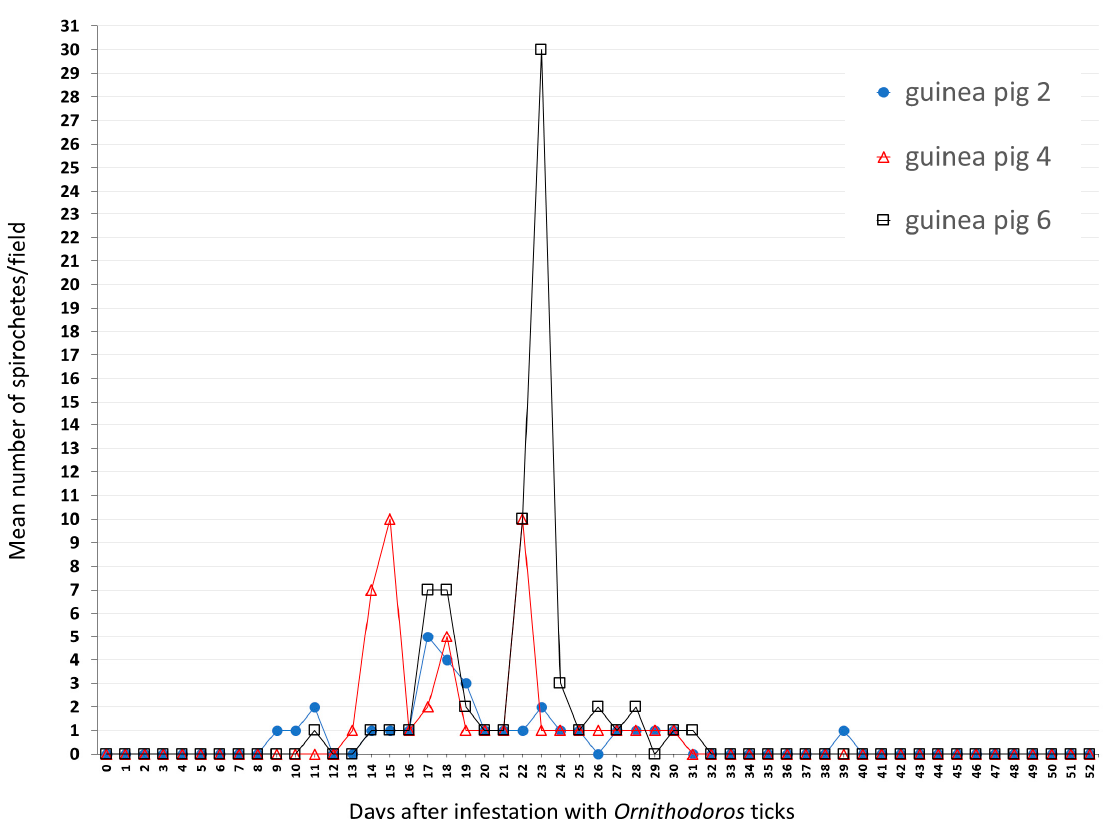
Figure 3. Results of dark-field examination of blood samples of guinea pigs according to the number of days after infestation with Ornithodoros cf. tabajara from Buíque (guinea pig 2), Floresta (guinea pig 4) and Serrita (guinea pig 6). Values presented as the mean number of motile spirochetes per microscope field at 200× magnification in each sampled day.